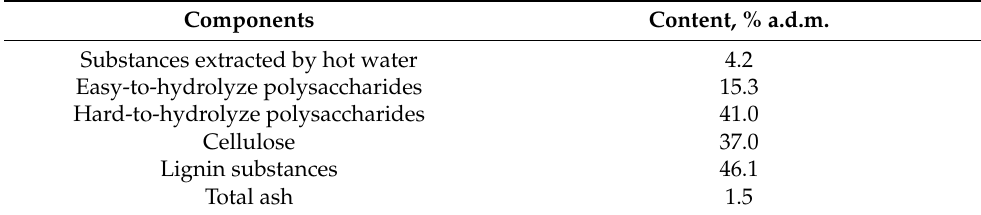
Table 8. Chemical composition of tan bark Larix sibirica Ledeb, % a.d.m. [108,109]. Components Substances extracted by hot